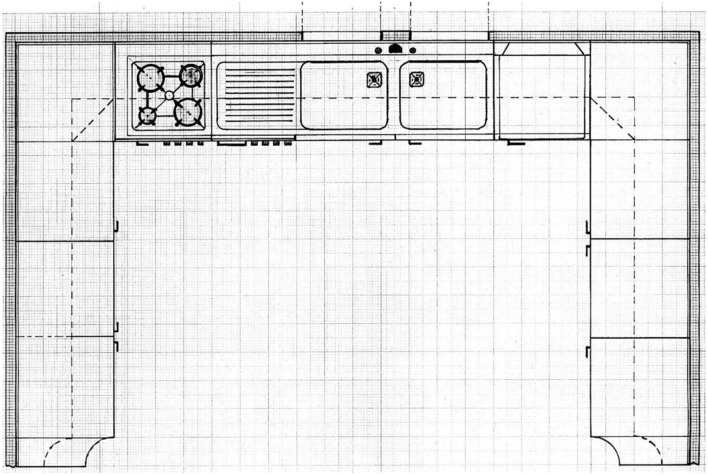
Experimental table.